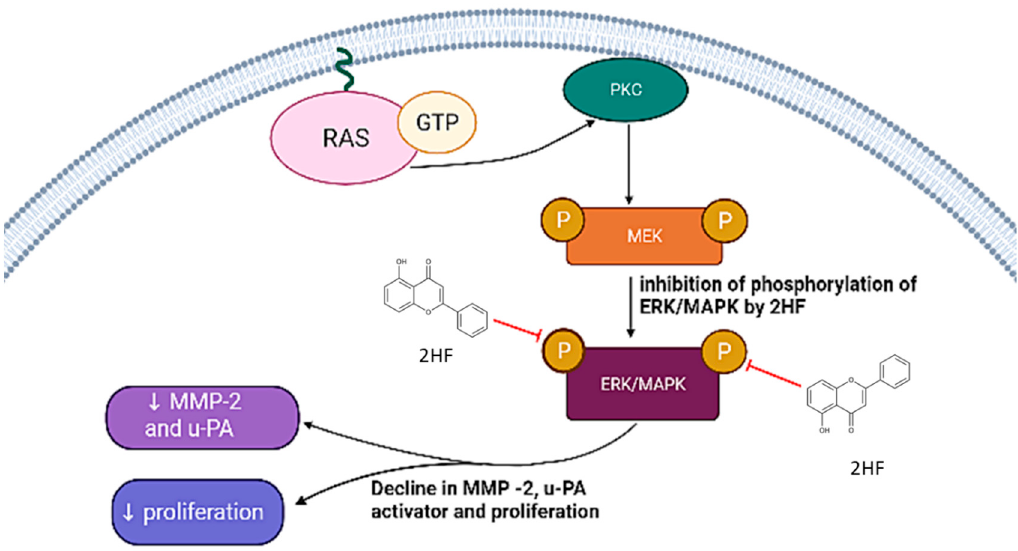
Figure 3. Inhibition of the MAPK pathway by 2 ′ -Hydroxyflavanone